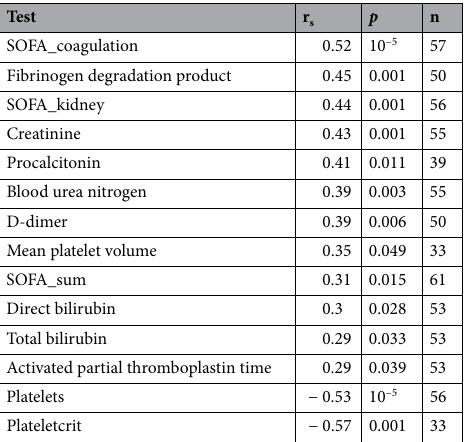
Table 4. Correlation of plasma NPC2 and clinical tests of moribund sepsis patients. Correlation coefficients (r s ) were obtained by performing the Spearman’s rank-order